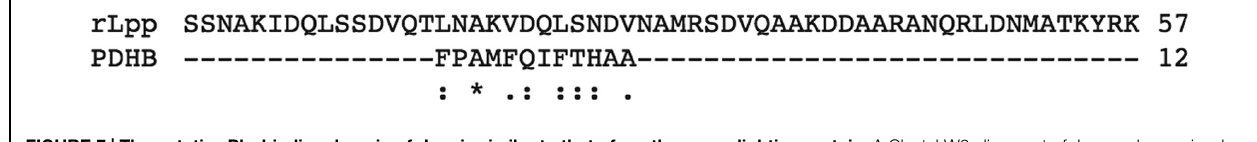
to plasmin by host factors tPA and uPA (Lähteenmäki et al.,